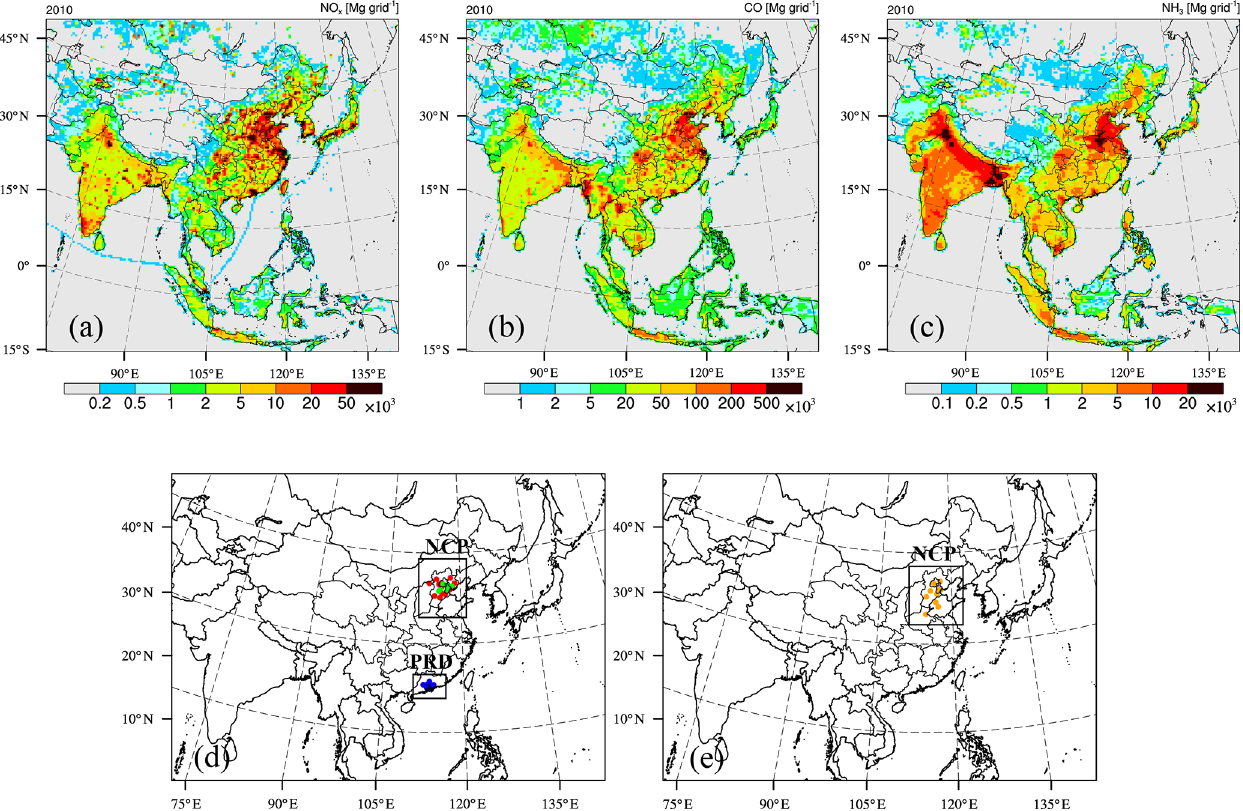
Figure 1. Modeling domains of the participating models, except M13 and M14, along with spatial distributions of the total emissions of (a) NO x , (b) CO, and (c) NH 3 in 2010 provided by MICS-Asia III and the distributions of observation stations of (d) NO 2 and CO over the NCP and PRD regions, as well as (e) NH 3 over the NCP region. The horizontal resolution is 45km × 45km. Note that domains of M13 and M14 are shown in Fig. 7 and that only 6 of 19 observational sites (green) over the NCP region have CO